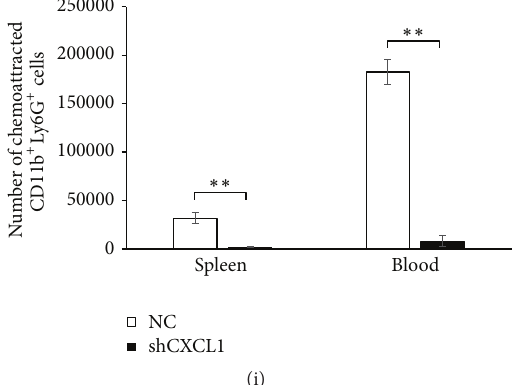
Figure 3: Knockdown of CXCL1 expression in 3LL cells decreases the number of neutrophils in vivo . 5 × 10 5 3LL/NC or 3LL/shCXCL1 cells were inoculated subcutaneously (s.c.) into C57BL/6J mice. At day 16, mice were scarified. The CD11b + Ly6G + neutrophils in peripheral blood were detected as described in the materials and methods. Representative flow cytometric graph (a) and percentage of CD11b + Ly6G + neutrophils in peripheral blood (b) were analyzed. Each dot plot represents an individual mice; horizontal lines are shown as mean of each group. (c) Flow cytometric analysis of the frequency of CD11b + Ly6G + neutrophils in bone marrow from mice inoculated with 3LL/NC